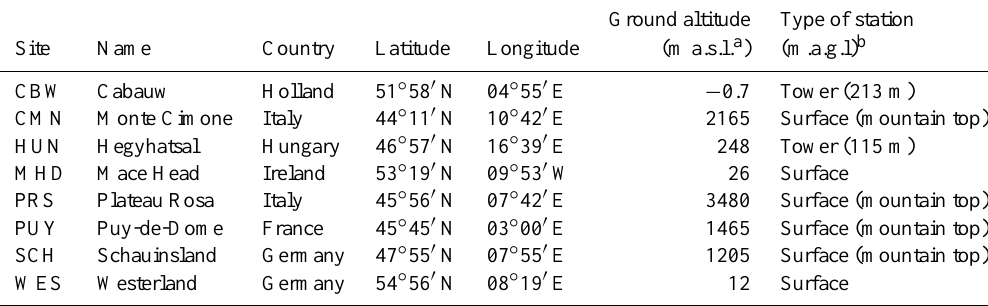
Table 3. Ground station acronyms and geographical